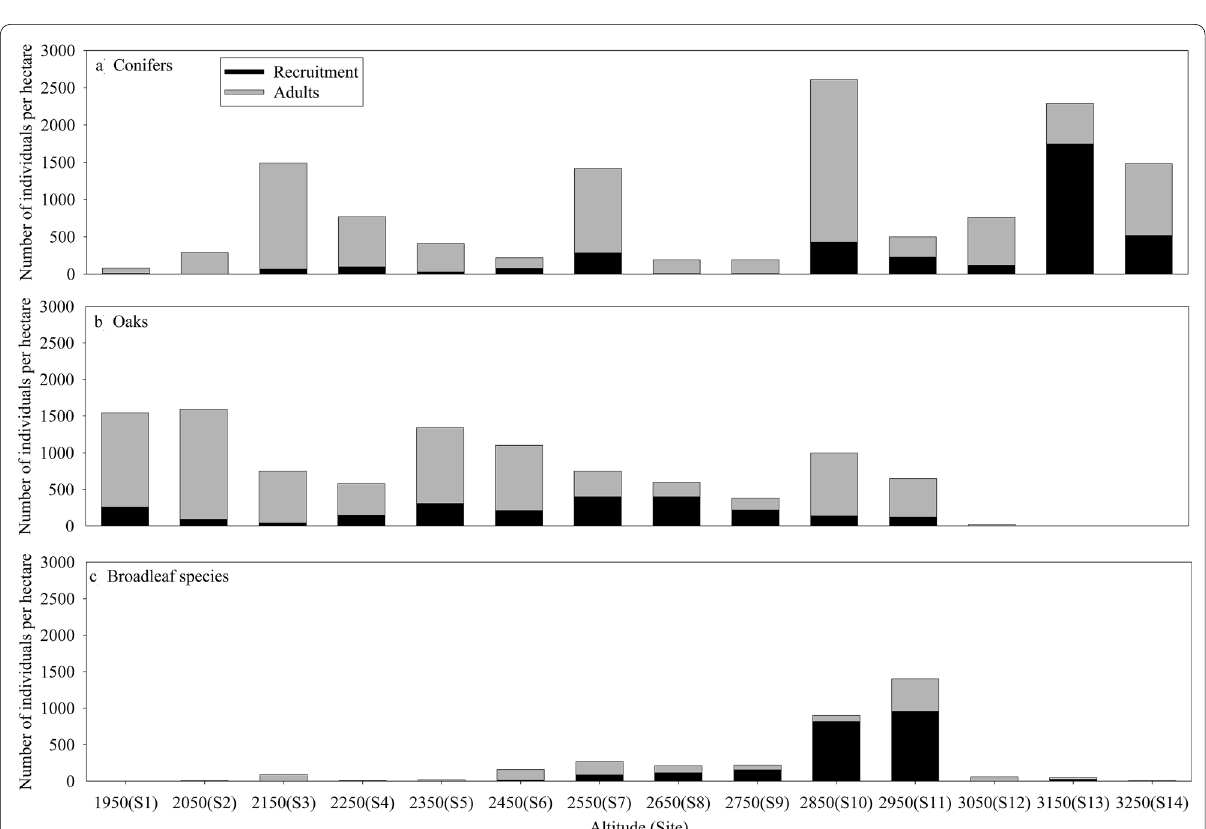
Fig. 2 Number of individual per hectare of adults (gray bars) and by recruitment (black bars) for a conifers, b oaks, and c other broadleaf species along to altitudinal gradient